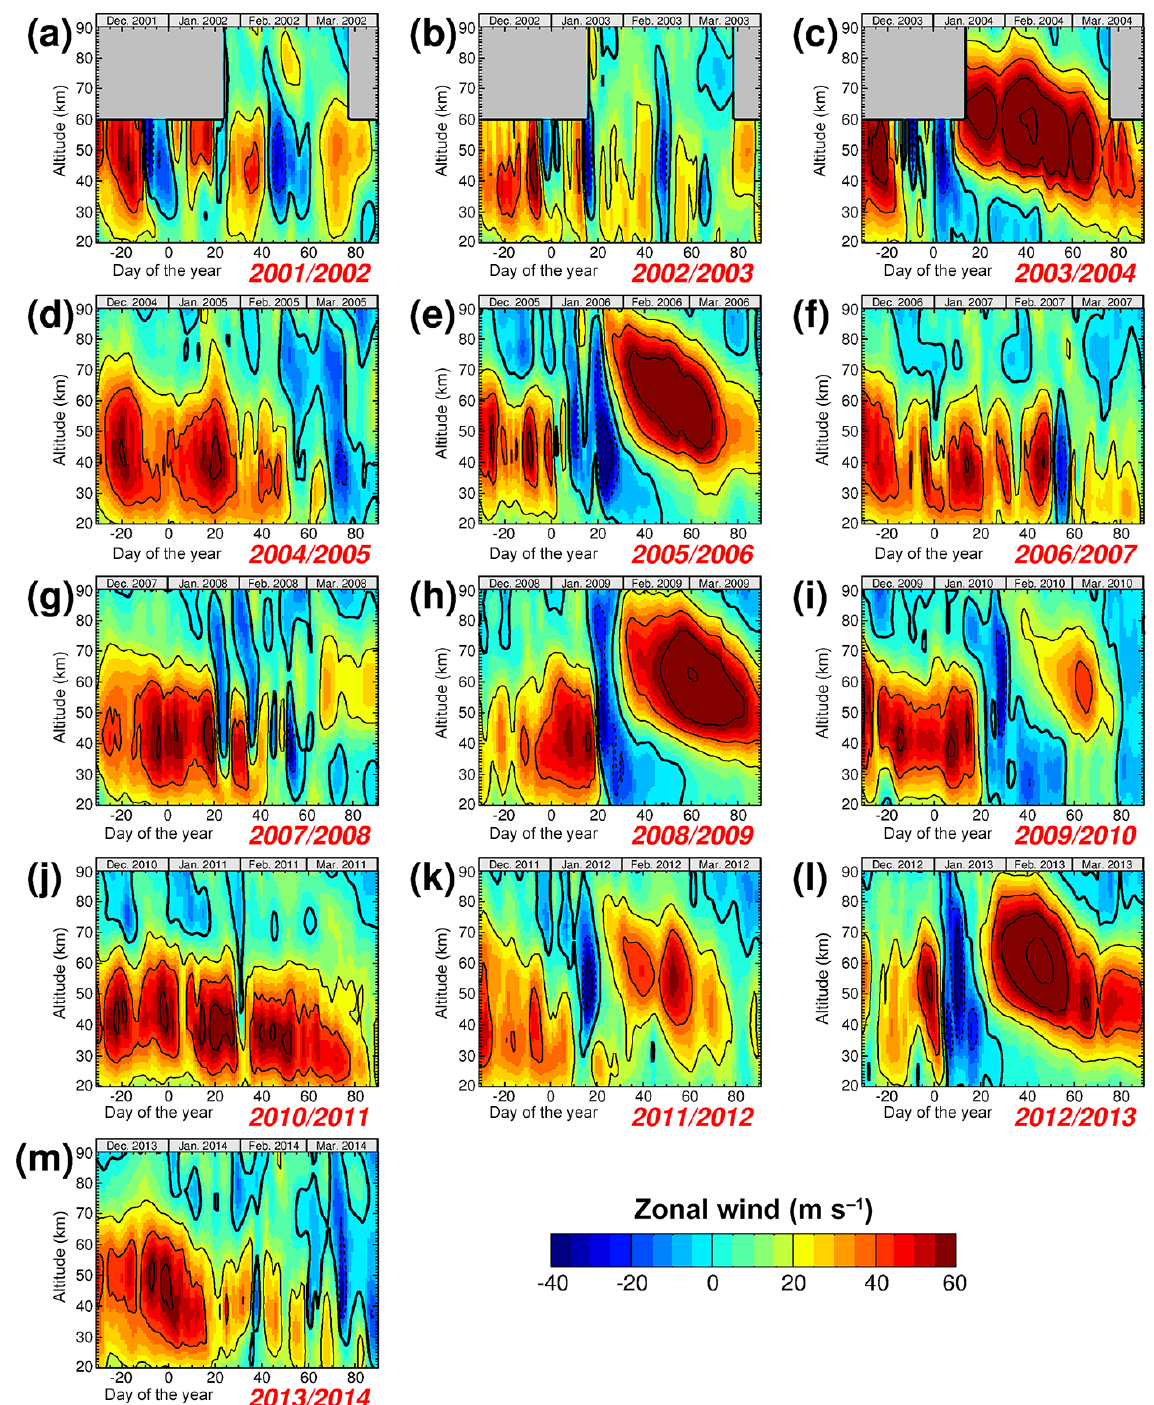
Figure 1. Altitude–time cross-sections of daily 60–80 ◦ N zonal average zonal wind in ms − 1 from ERA-Interim, MLS Aura and SABER combined. The time scale on the x axis is given in “days of the year” (doy) with 1 January 00:00UT as doy = 0. Overplotted contour lines have a contour increment of 20ms − 1 . Westward (eastward) winds are indicated by dashed (solid) contour lines. The zero wind line is bold solid. Times and altitudes where no data are available are marked in